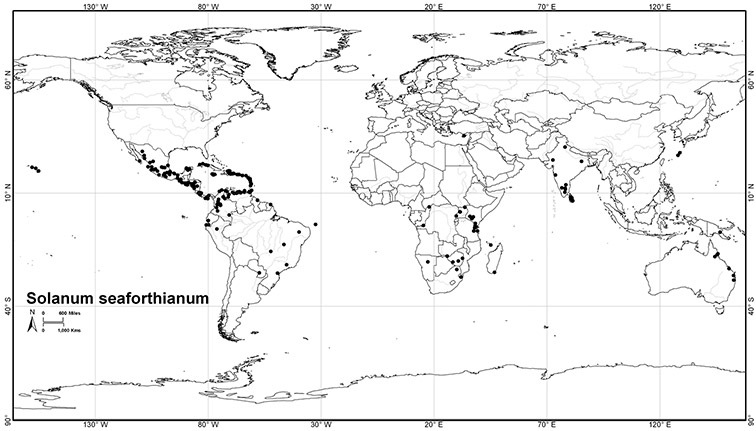
Distribution of Solanum seaforthianum Andrews.